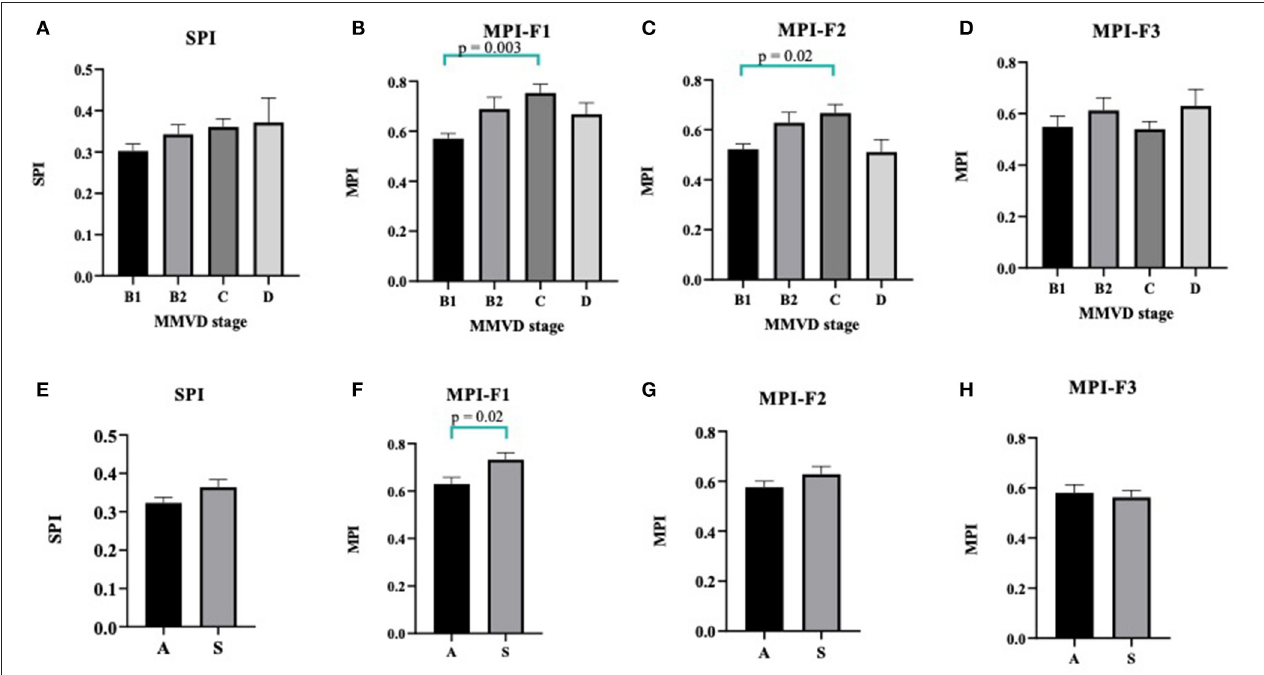
FIGURE 5 | Column bars represented mean CTI values of MMVD stages of SPI (A) , MPI-F1 (B) , MPI-F2 (C) , and MPI-F3 (D) . Data were expressed as mean ± SEM and were compared using ANOVA and post-hoc Tukey’s test at p < 0.05. For asymptomatic [A] vs. symptomatic [S] MMVD, CTI values of SPI (E) , MPI-F1 (F) , MPI-F2 (G) , and MPI-F3 (H) . Data were expressed as mean ± SEM and compared using unpaired t -test at p < 0.05. CTI, cardiac time interval; MMVD, myxomatous mitral valve disease; SPI, systolic performance index; MPI, myocardial performance index.